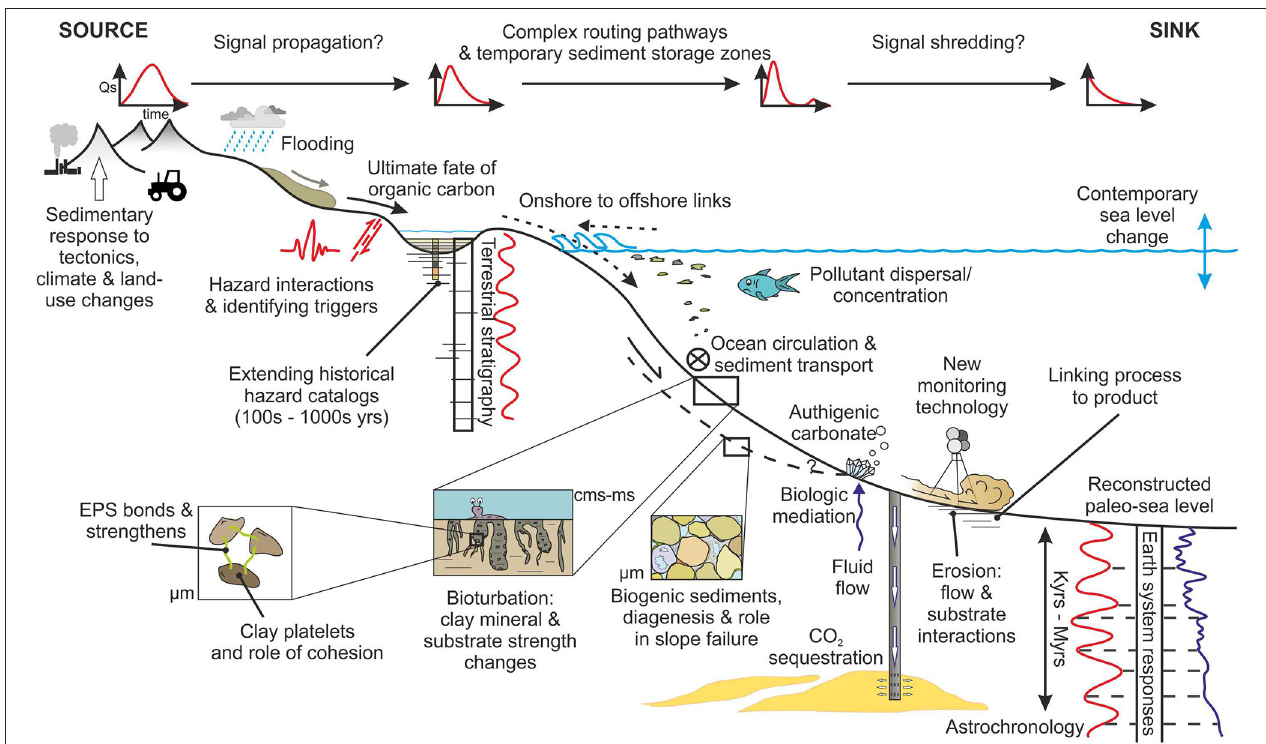
FIGURE 1 | Illustration of the range of sedimentological, stratigraphic, and diagenetic research themes highlighted by this article, Sedimentology and Society, Life and Sedimentology, and Sedimentary System Response to External Forcing. EPS, extracellular polymeric substances; Qs, sediment